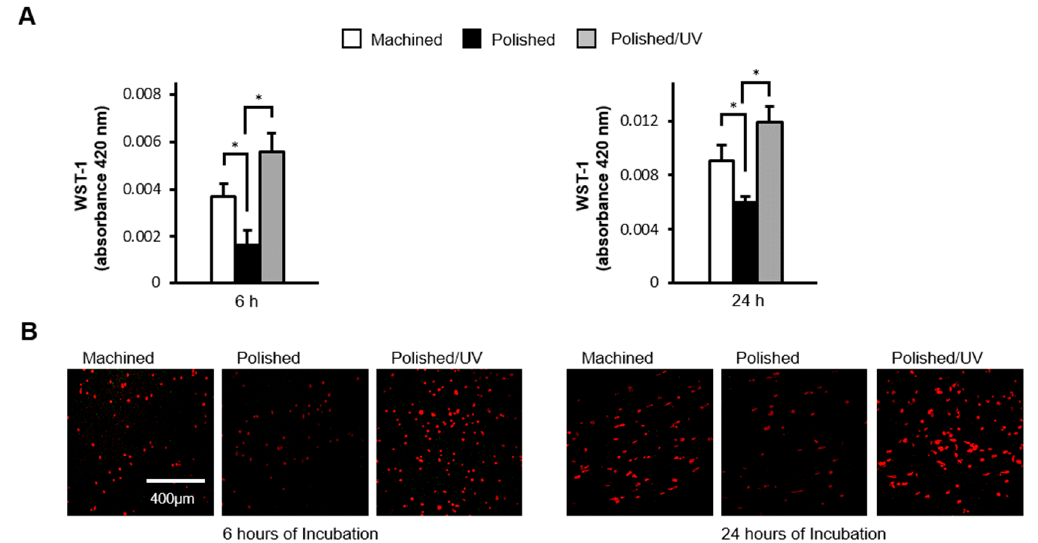
Figure 5. Human epithelial cell attachment to titanium surfaces during initial culture. Human epithelial cells were cultured for 6 and 24 h on the machined surface, polished surface and polished/UV surface. ( A ) Numbers of attached cells after 6 and 24 h of incubation were determined by using a WST-1 assay (* P < 0.05). ( B ) Confocal microscopy images of human epithelial cell cultures grown on titanium disks. Representative confocal microscopy images of cells stained with rhodamine-phalloidin, for actin filaments (red). Scale bar = 400 μ m.